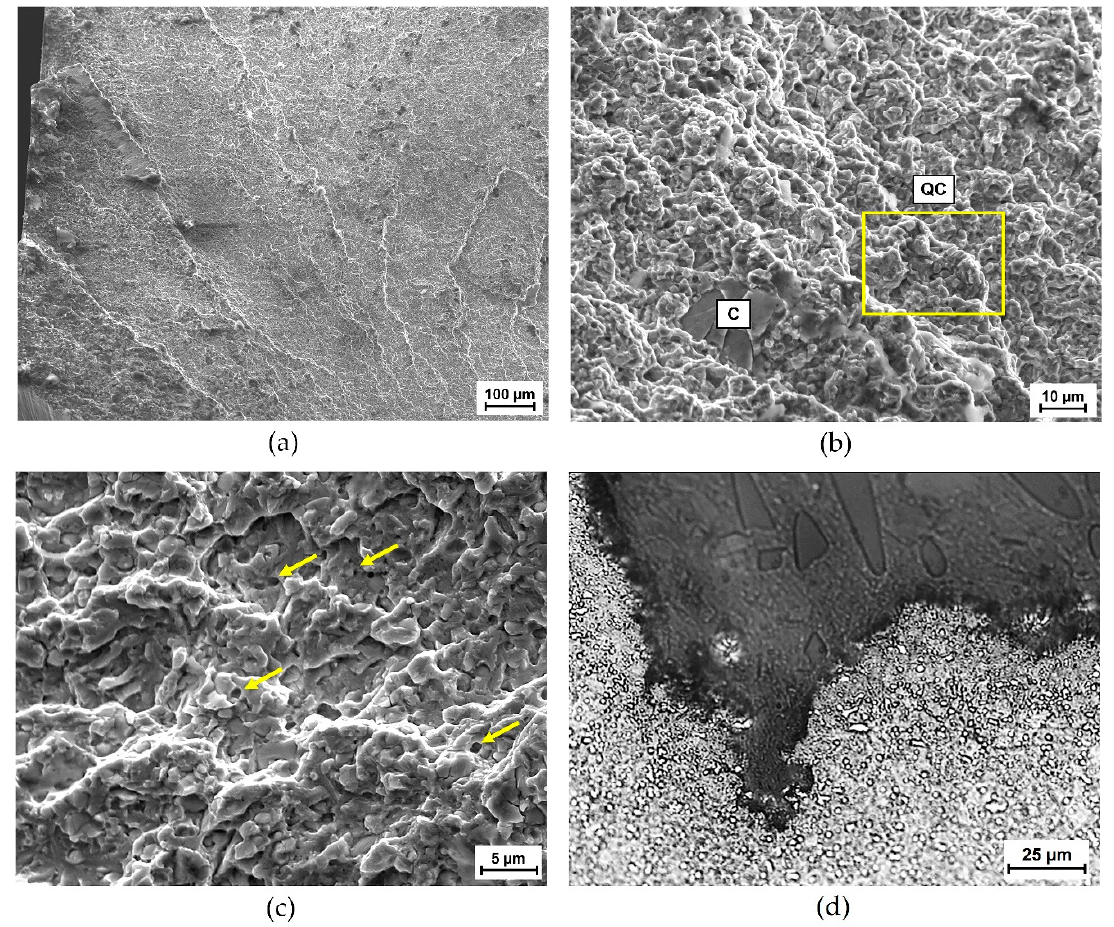
Figure 5 . XRD diffractogram recorded on the bulk taps after CHT_5.